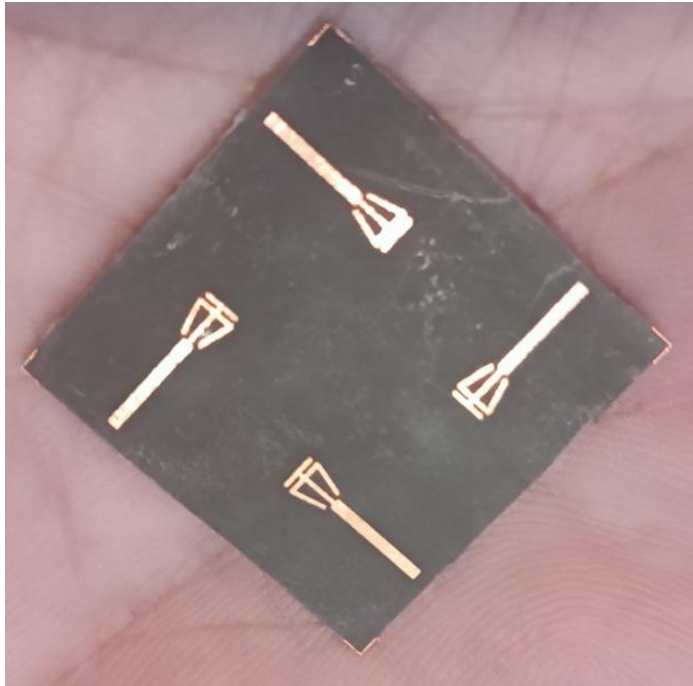
Figure 5. Fabricated prototype of proposed MIMO antenna.